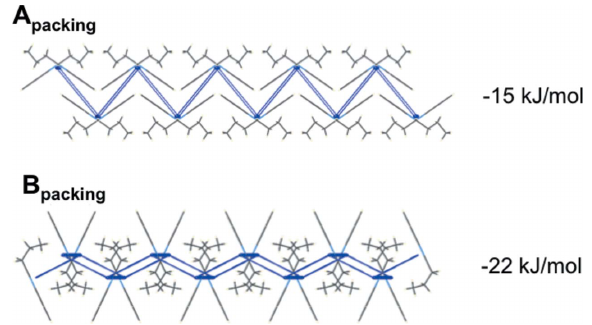
Figure 8 Interactions between type A (top) and type B (bottom) hydrogen-bonded chains in 2PrBzIm.